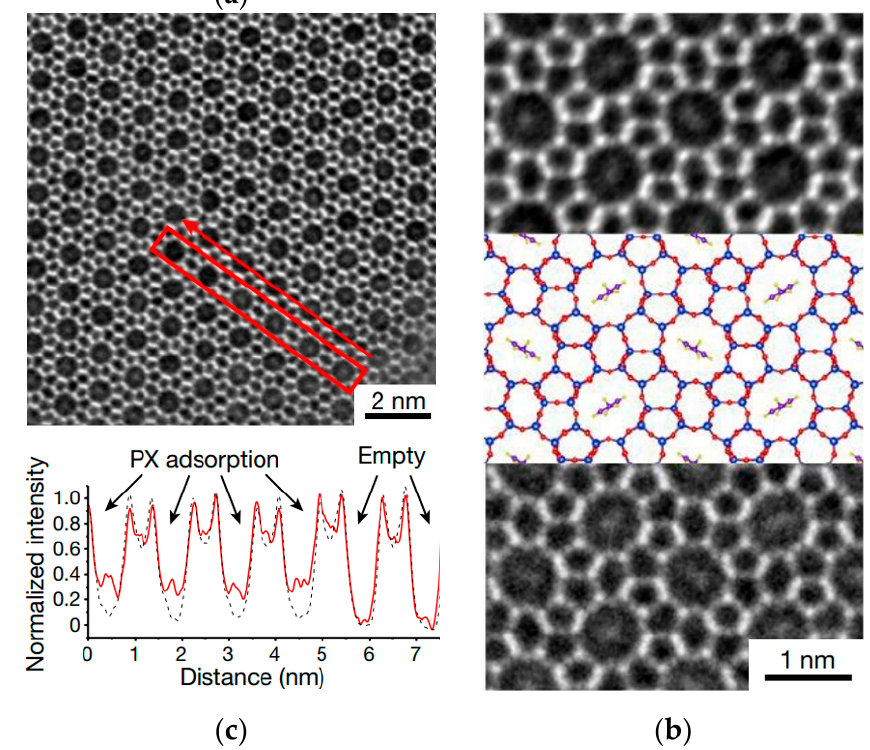
Figure 13. ( a , b ) iDPC-STEM image ( b , top ), the structural model ( b , middle ) and the simulated image ( b , bottom ); ( c ) shows the corresponding intensity profile acquired from the red-framed region in ( a ).Reprinted/adapted with permission from Ref. [102]. Copyright 2021, Springer